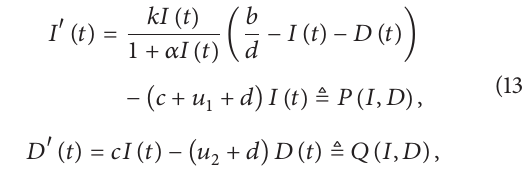
(a) When 𝜏 = 4 , then the solution (𝑆(𝑡),𝐼(𝑡),𝐷(𝑡)) converges to the endemic equilibrium 𝐸 ∗ = (4.4138,5.0136,5.726) as 𝑡 → ∞ Figure 4: Taking 𝑏 = 6 , 𝛼 = 1 , 𝑑 = 0.4 , 𝑘 = 3 , 𝑐 = 1 , 𝑢 1 = 0.8 , and 𝑢 2 = 0.5 , then 𝑅 0 = 20.4545 > 1 , 𝑝 1 = −6.9925 < 0 , 𝑞 1 = −8.2363 < 0 , and = −0.4091 < 0 . And set the initial condition (𝑆(𝜃),𝐼(𝜃),𝐷(𝜃)) = (1,2, 2) , 𝜃 ∈ [−𝜏,0] . 𝑟 1